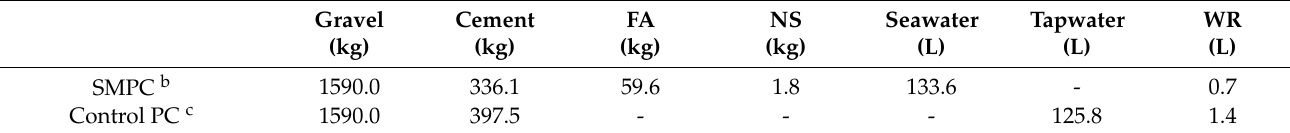
Table 5. The mix proportions a of the optimum SPMC and Control PC (per m 3